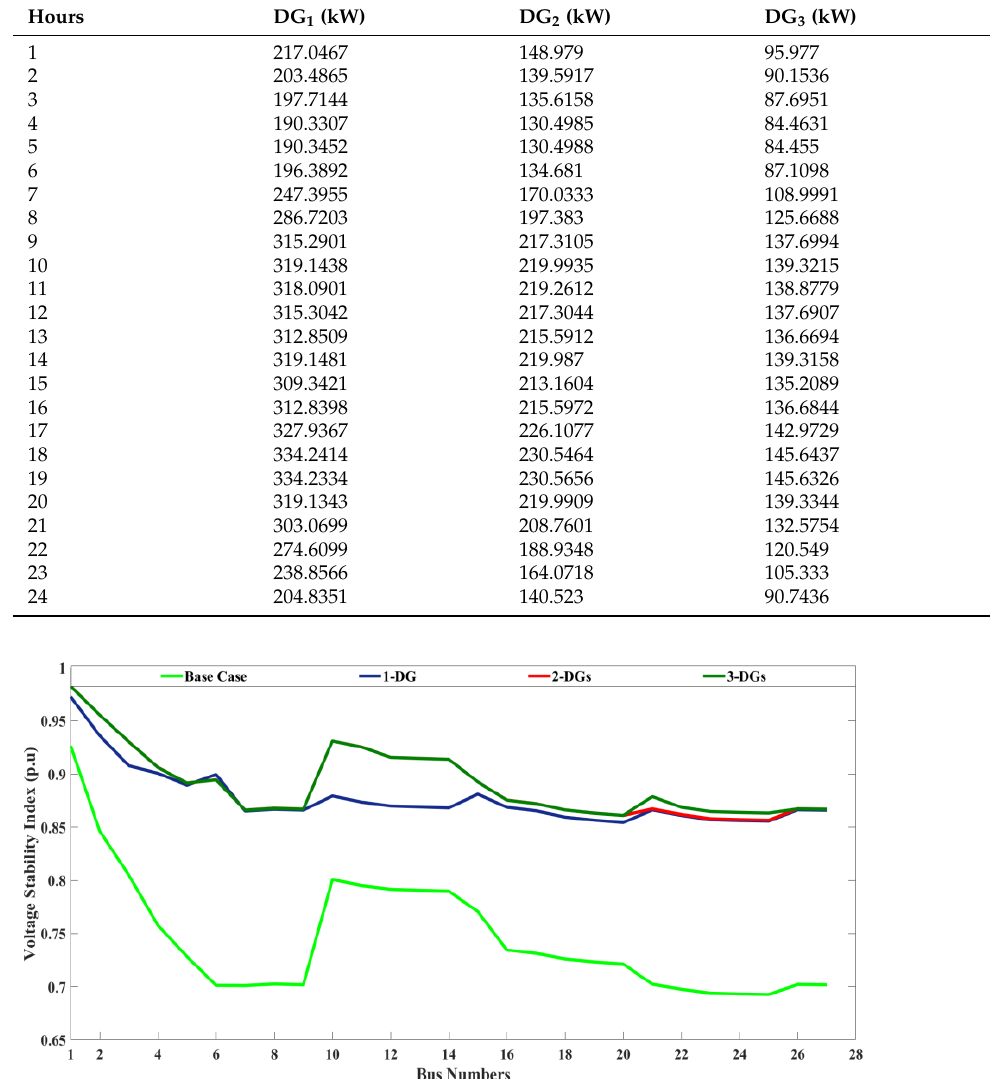
Figure 12. Voltage Stability Index for 28 Test System.